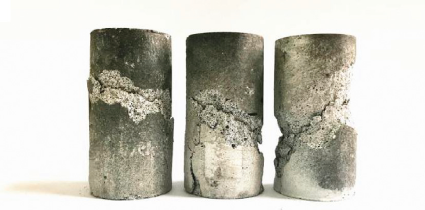
Figure 6: The failure type of the